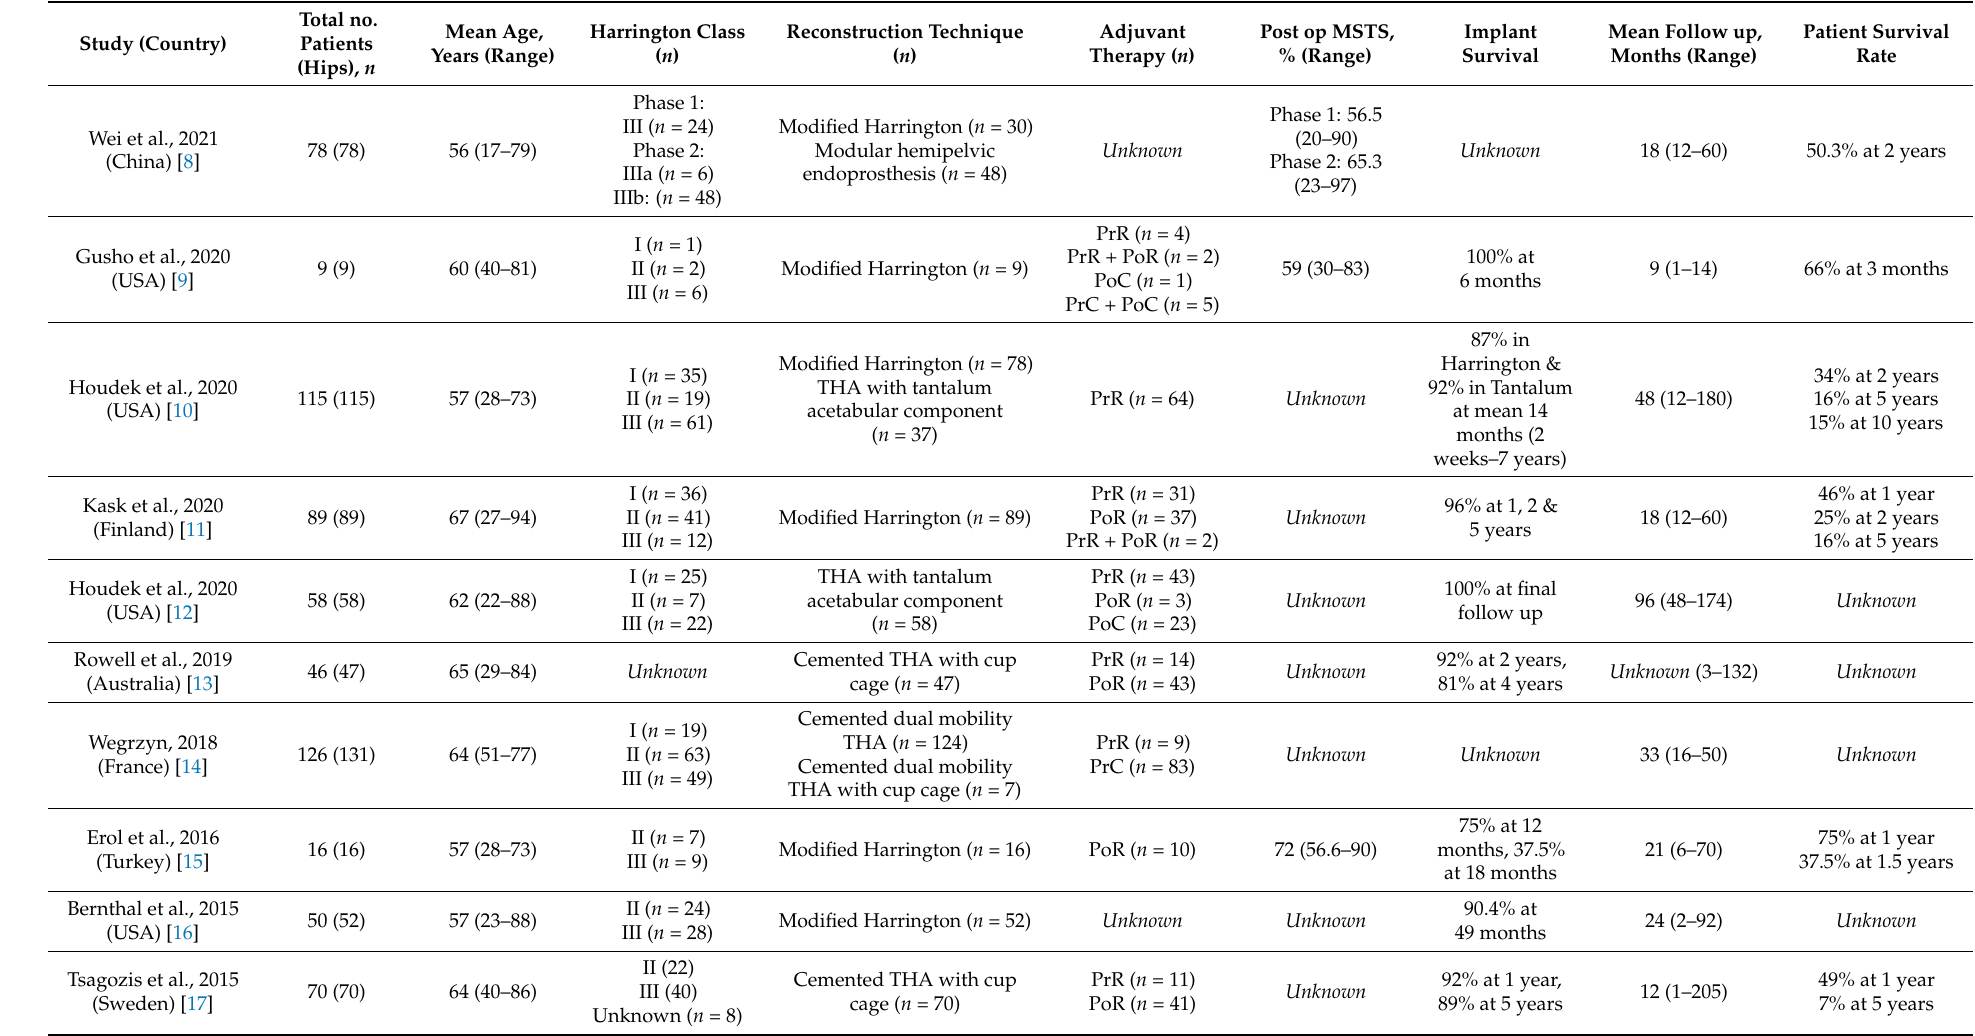
Table 1. Summary of